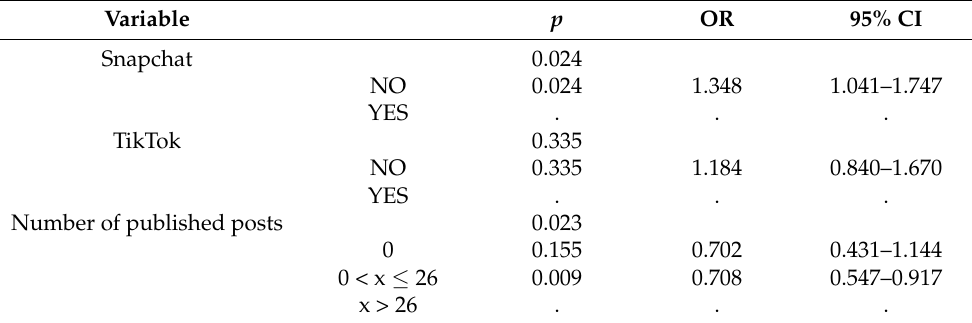
Table 4. Multinomial logistic regression analysis of association between other social media platforms use, number of published posts and augmentation